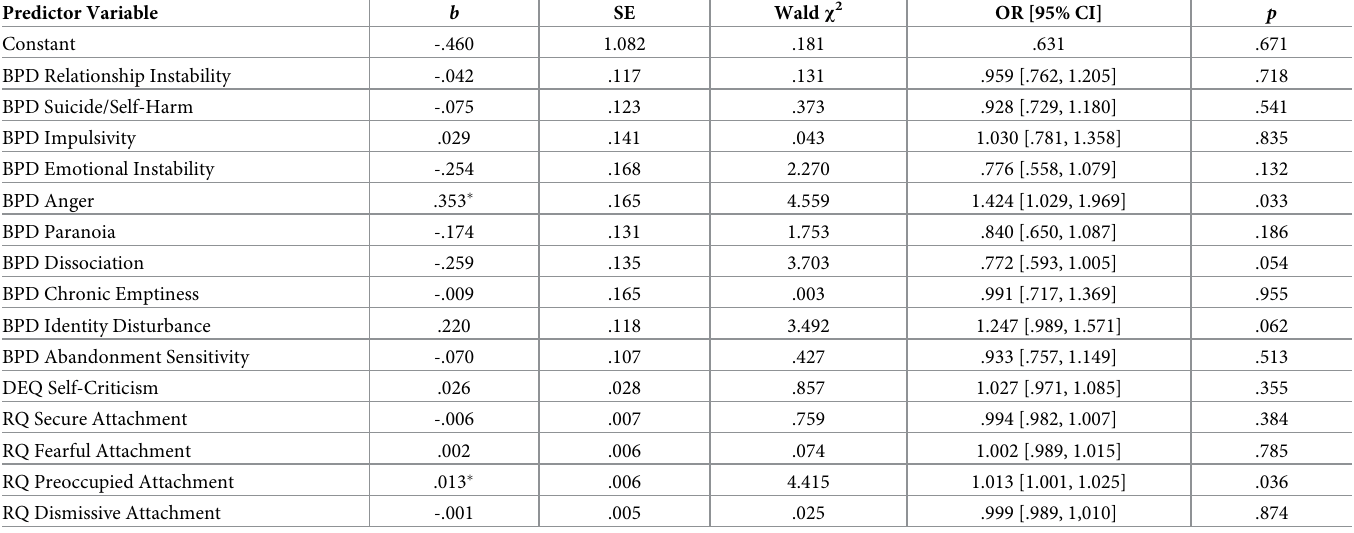
Table 4. Individual regression coefficients (b), standard errors (SE), Wald chi-square statistics (Wald χ 2 ), Odds Ratios (OR) with 95% confidence intervals [95% CI], and p values for each individual predictor for the likelihood of being categorised as a ‘non-responder’ in regard to BPD symptom severity after treatment. Predictor